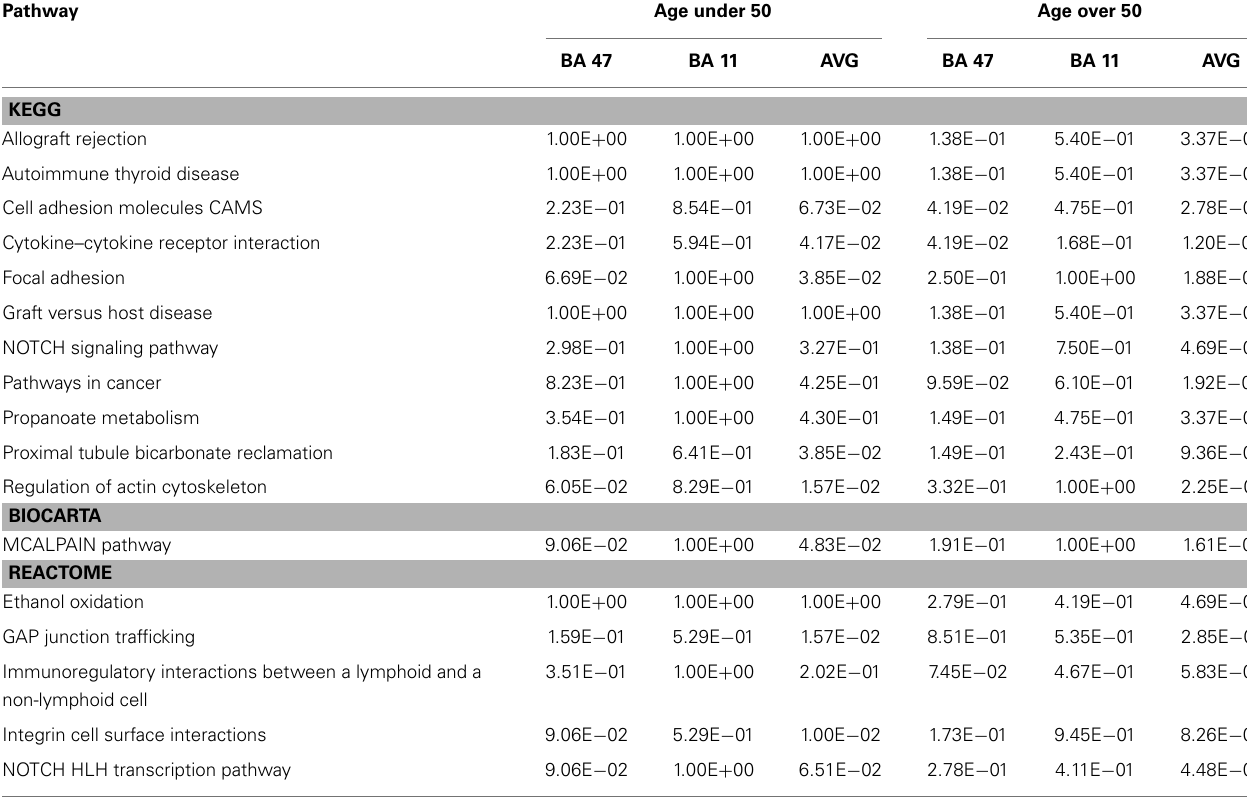
Table 3 |Top pathways identified by genes showing negative correlations withVSNL1 expression